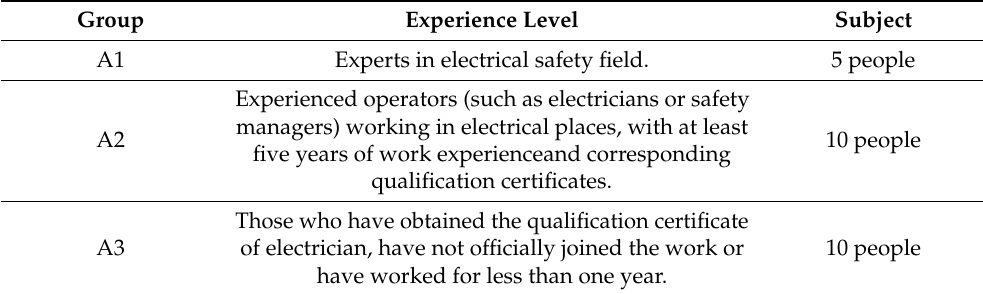
Table 5. Explanation of the division of experimental